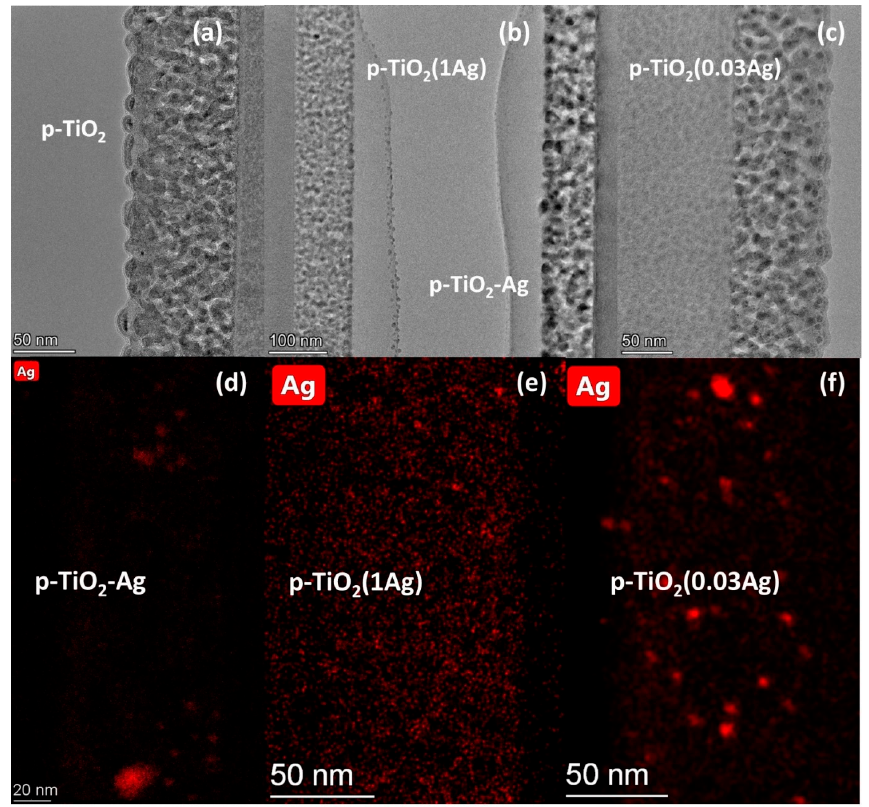
Figure 2. Cross-sectional HRTEM images of the ( a ) p-TiO 2 , ( b ) p-TiO 2 (1Ag) (left) and p-TiO 2 –Ag (right), and ( c ) p-TiO 2 (0.03Ag) samples. EDS elemental maps showing Ag particles of the ( d ) p-TiO 2 –Ag, ( e ) p-TiO 2 (1Ag) and ( f ) p-TiO 2 (1Ag) coatings.